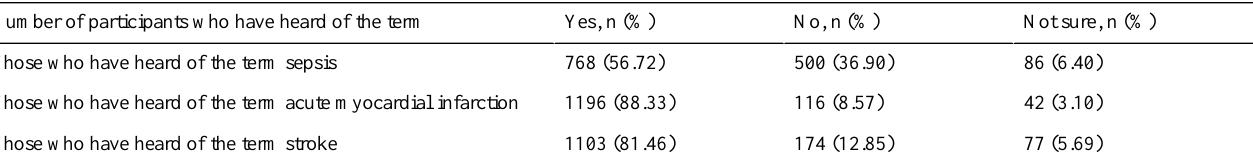
Table 2. Participant knowledge of the terms sepsis, myocardial infarction, and stroke